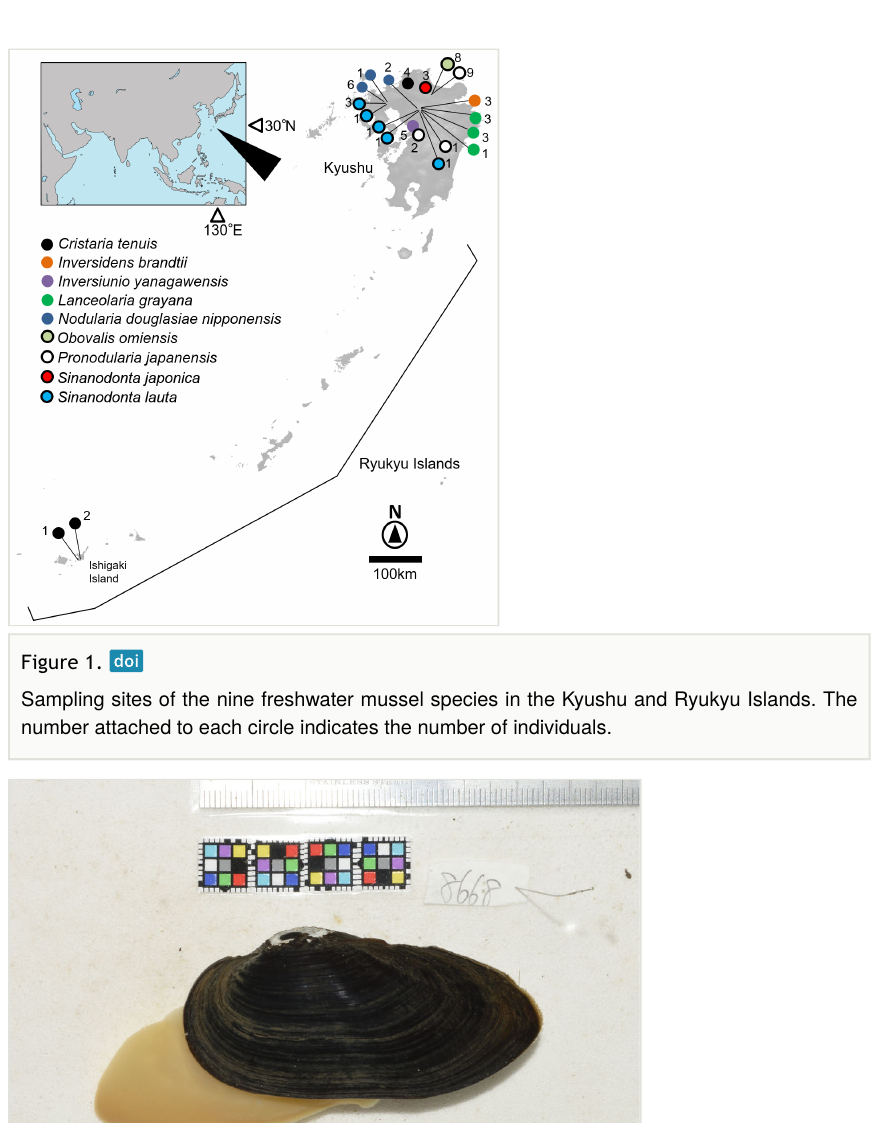
Figure 2. A live Nodularia douglasiae nipponensis